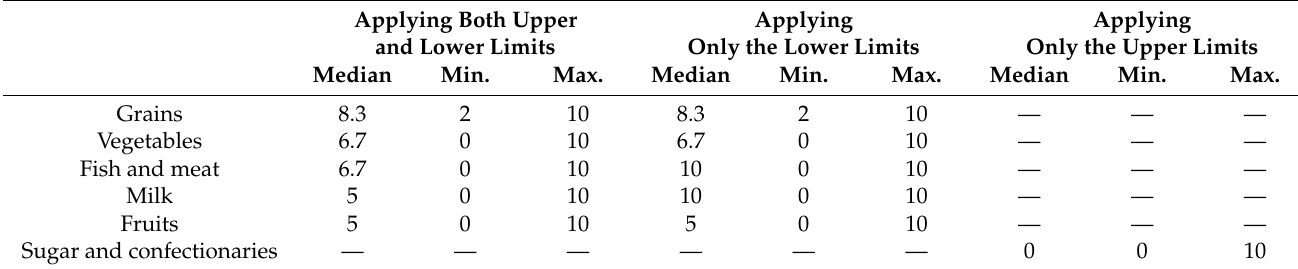
Applying Applying Only the Lower Limits Only the Upper Limits